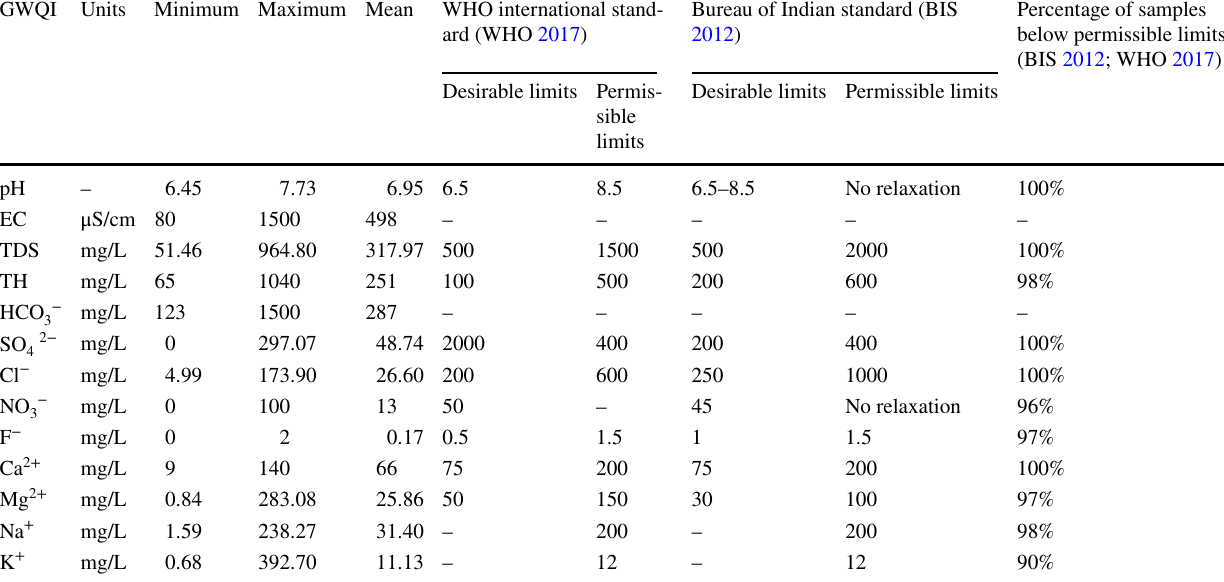
Table 2 Descriptive statistics of the physicochemical parameters of groundwater in the Kathua region, Jammu and Kashmir, Northern India GWQI Units